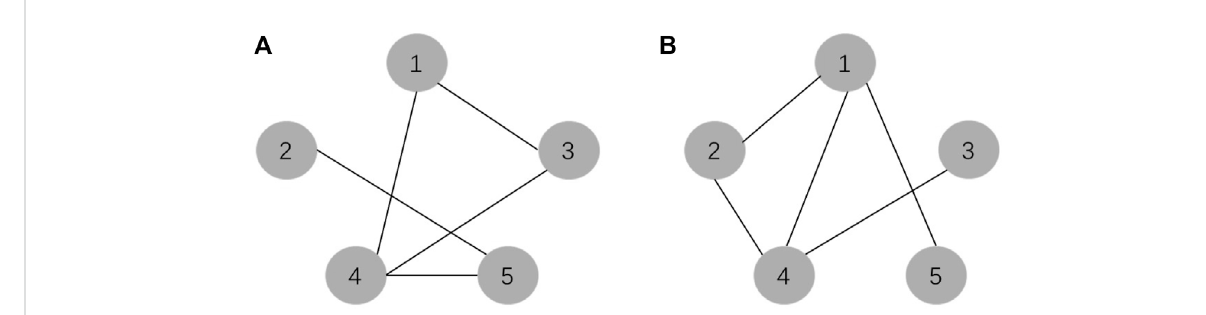
FIGURE 1 (A) Network associated with adjacency matrix A . (B) Network associated with adjacency matrix B